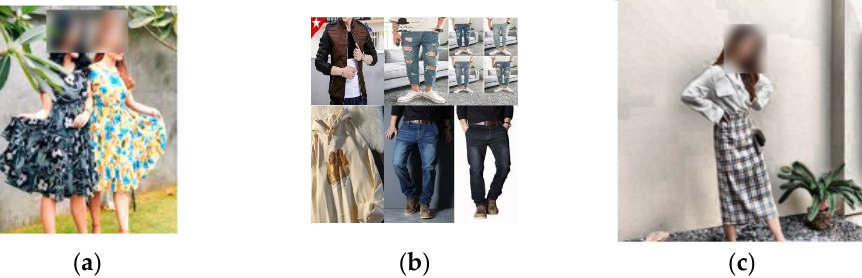
Figure 10. Samples of training images after image augmentation ( a ) Brightening, ( b ) Mosaic, and ( c ) CLAHE results. Table 4. The number of images generated by pseudo-labeling and data augmentation.